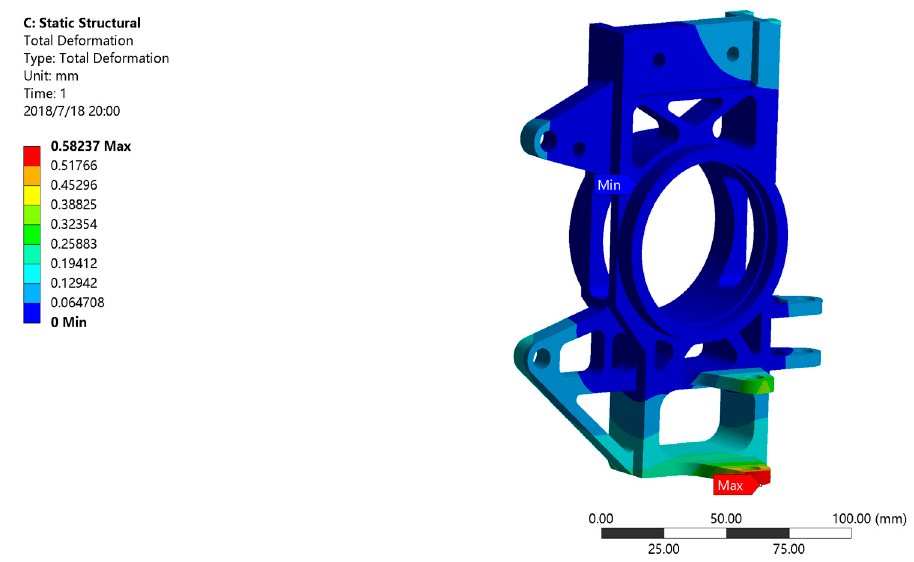
Figure 13. Strain cloud. Figure 13. Deformation contour.